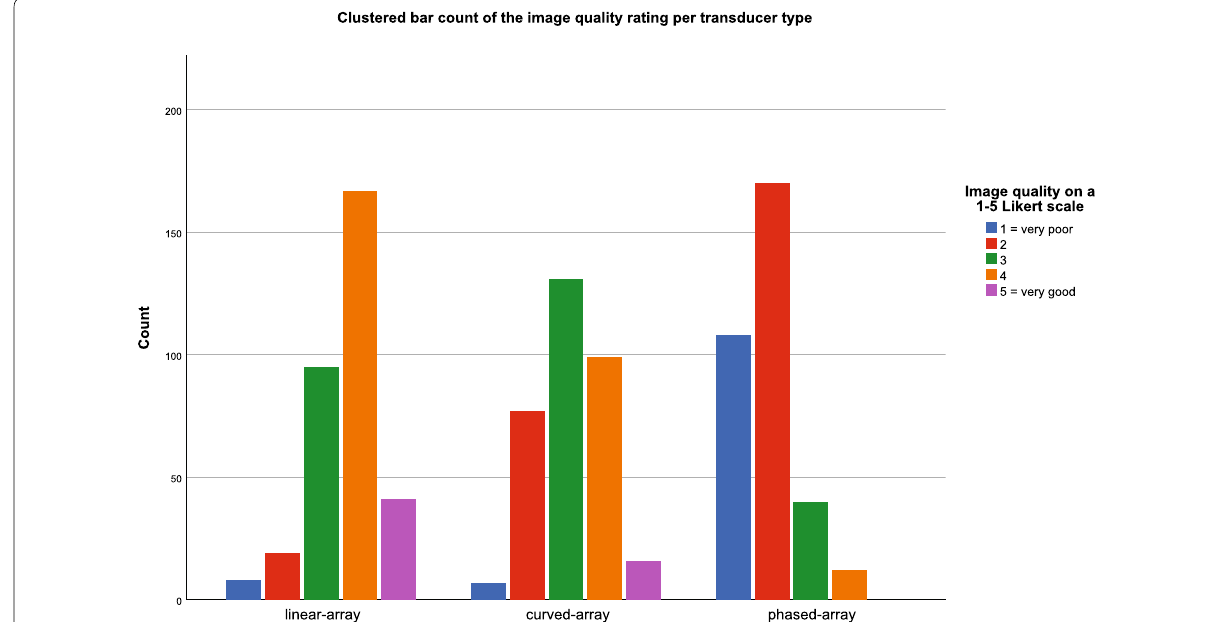
Fig. 6 Clustered bar count of the image quality rating per transducer type. The Wilcoxon signed-rank test showed a significant difference in image quality between all three transducers ( p < .0001)